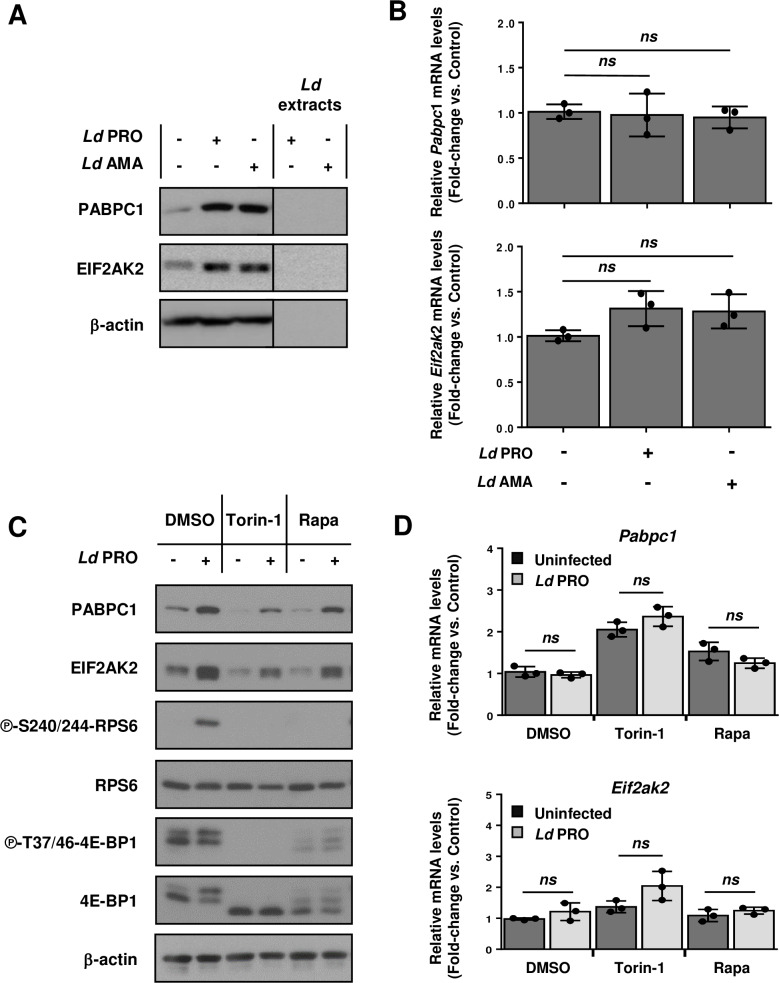
Upregulation of PABPC1 and EIF2AK2 in macrophages infected with L. donovani is mTOR-dependent.(A-B) BMDM cultures were inoculated with Ld AMA, Ld PRO or left uninfected for 6 h. (C-D) Cells were pre-treated with 200 nM of Torin-1, 20 nM rapamycin (Rapa) or DMSO for 2 hours before infection. (A, C) Total levels of PABPC1 and EIF2AK2 were monitored by Western blotting. (C) Phosphorylation status of mTOR downstream targets RPS6 and 4E-BP1. (B, D) Relative mRNA amounts of Pabpc1and Eif2ak2 (normalized to Actb) were measured by RT-qPCR. (A, C) Results are representative of three independent experiments. (B, D) Data are presented as mean ± SD (biological replicates, n = 3). **p <0.01, ***p <0.001 (for the indicated comparisons), ns = non-significant. Protein extracts for Western blot analyses (A and C) originate from one of the three biological replicates employed to isolate RNA samples for RT-qPCR experiments (B and D, respectively).